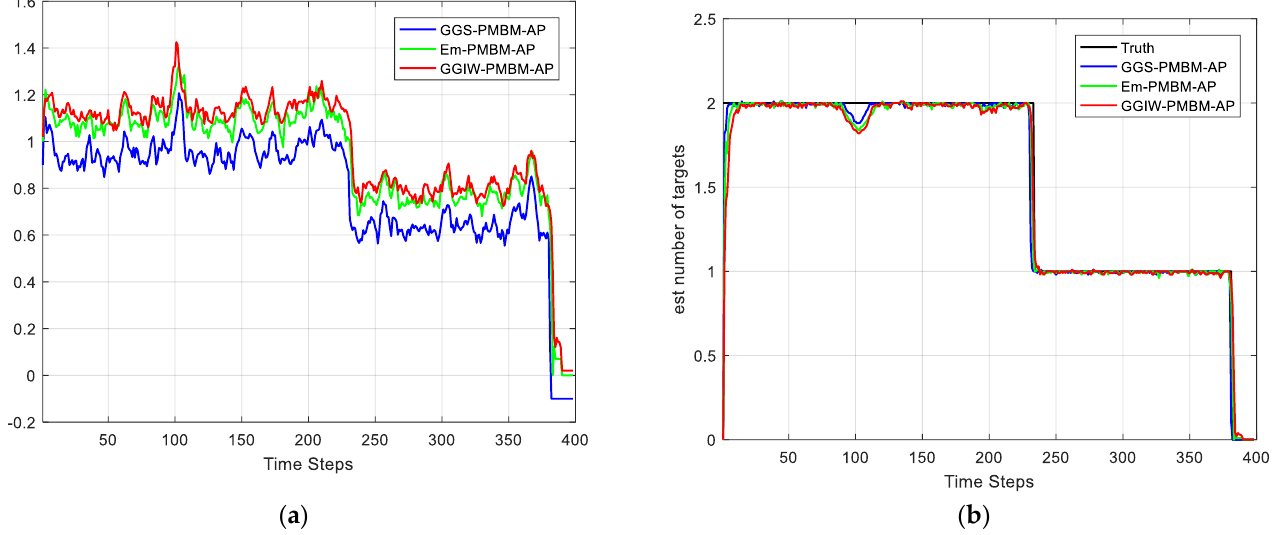
Figure 15. Averaged cardinality and cardinality error of GGS − PMBM − AP filter, Em − PMBM − AP filter and GGIW − PMBM − AP filter over 100 Monte Carlo runs. ( a ) Estimated number of targets, ( b ) cardinality error of targets estimation.